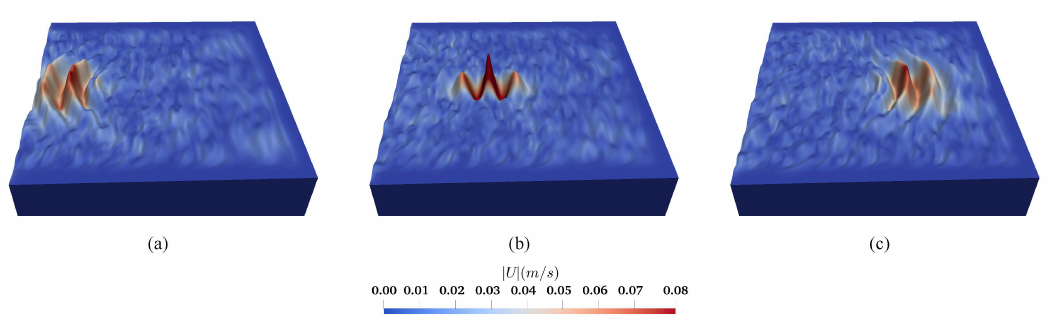
Figure 26. Velocity magnitude in the 3D focusing wave field. The time frames are t = 30 s, t = 35 s and t = 40 s from left to